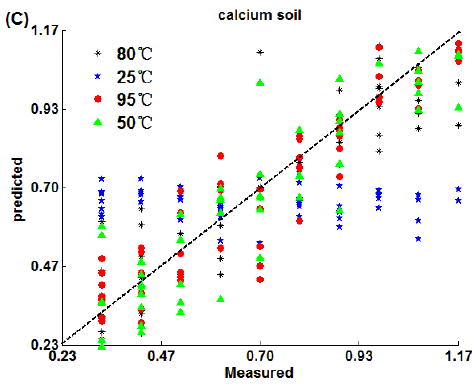
Figure 4. SPA-MLR algorithm prediction results: ( A ) black soil; ( B ) loess; ( C ) calcium soil.